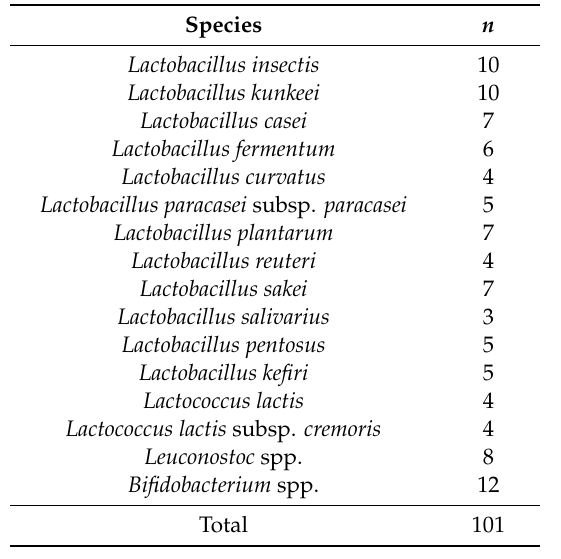
Table 2. Number of isolated microorganisms from the surface of various fruits or vegetables and the entire vegetable content in ready-to-eat (RTU) commercially available salads. Isolated Apples Pears Species ( n = 20) * ( n = 20) 1 Salmonella spp. Shigella